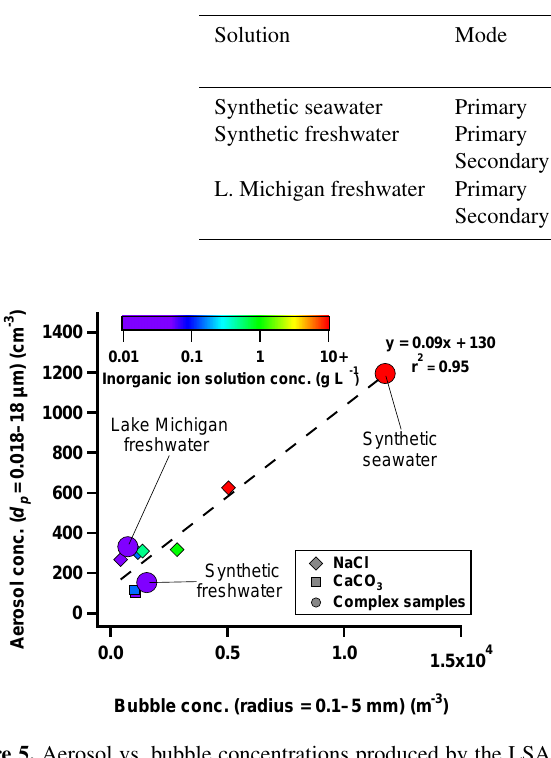
Figure 5. Aerosol vs. bubble concentrations produced by the LSA generator from solutions of NaCl and CaCO 3 of varying concentra- tions, Lake Michigan freshwater, synthetic freshwater, and synthetic seawater. A best-fit line is shown for the empirical relationship be- tween aerosol and bubble